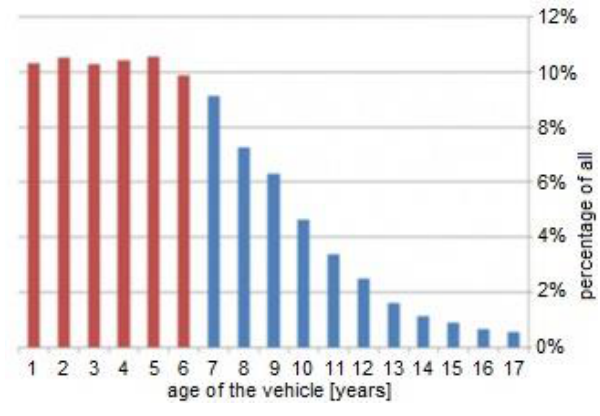
Fig. 4. Searching for used tractor units by their age [21] Mentioned above data concerning the search prefer- ences for used vehicles according to their year of produc- tion are indirectly reflected in the average time of use of a tractor unit in road transport companies. Of course, it is difficult to clearly define the economically justified service life of a tractor unit, as it depends on factors such as the intensity of use, annual mileage, type of work, etc. Howev-